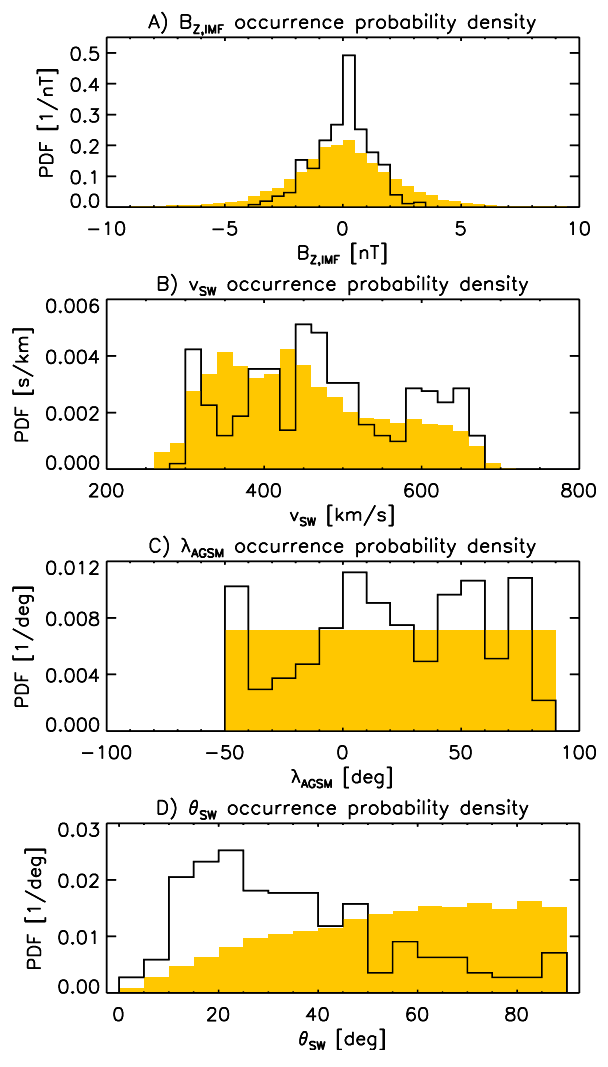
Fig. 2. Probability density functions (PDFs) of events from the half- period sample population (solid lines) and the basic population ob- tained from 7 months of OMNI SW data (yellow bars in panels A, B and D). Distributions are plotted against: (A) IMF B z , (B) SW flow speed v sw (C) AGSM longitude angle λ and (D) IMF cone an- gle ϑ sw . In panel (C) the basic population (yellow bars) is given by the constant PDF in the interval [− 50 ◦ , 90 ◦ ] . It should be noted that the longitude distributions are asymmetric, because the dawn flank magnetospheric regions were not covered by the THEMIS coast phase orbits before the injections into the main phase orbits took place in September